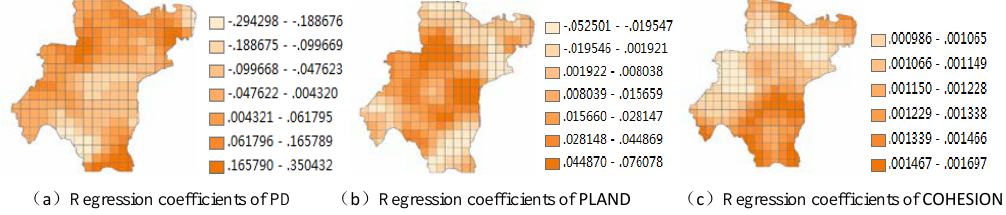
Table 5 Comparison of Model Parameters